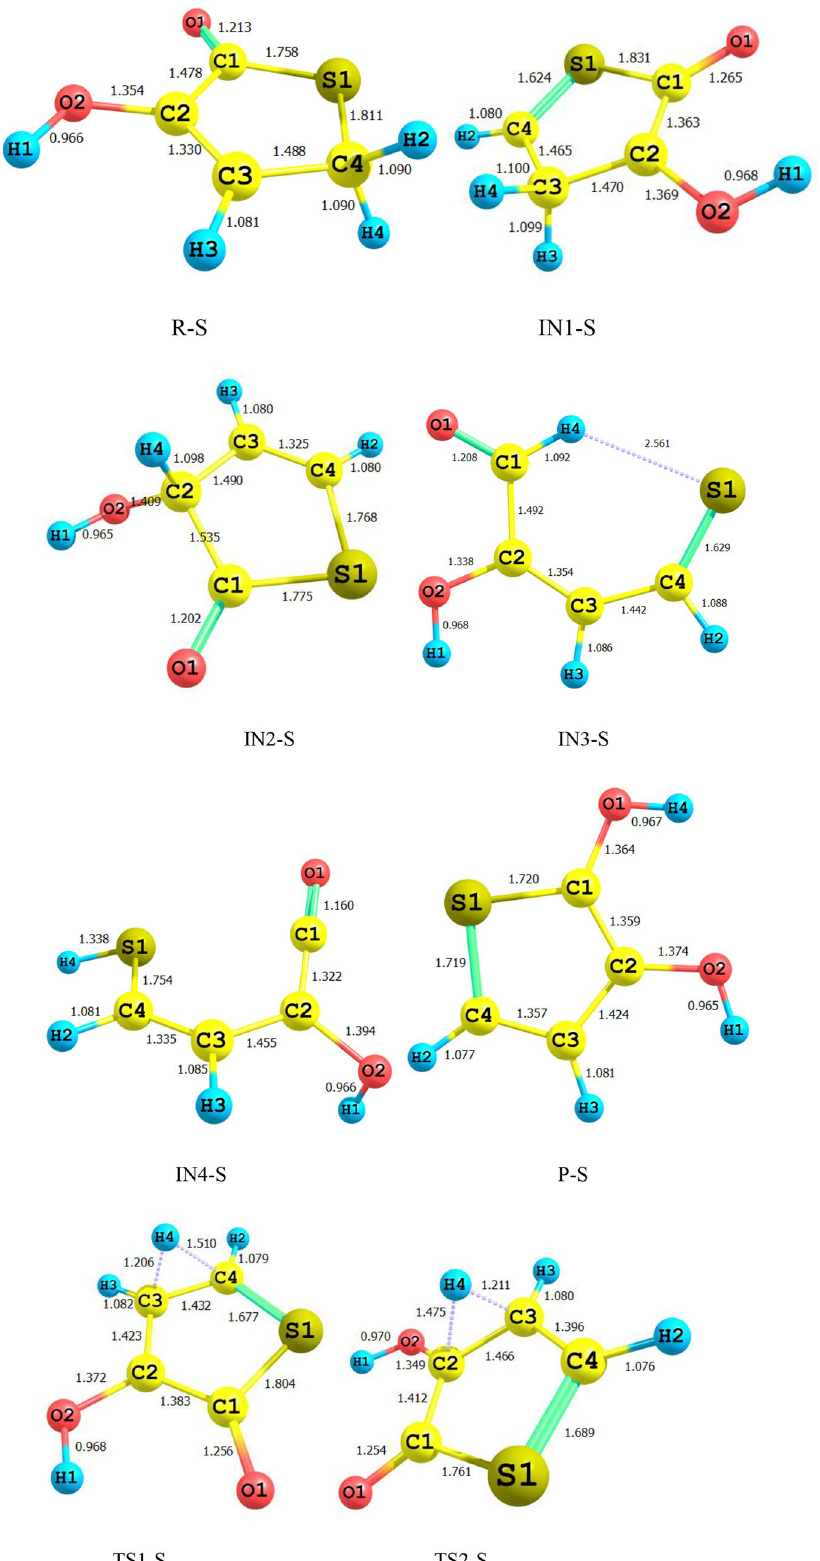
Figure 7. Lowest structures of all stationary points in 3-hydroxythiophen-2(5H)-one unimolecular reaction obtained at the M06-2X/Jun-cc-pV(T+d)Z